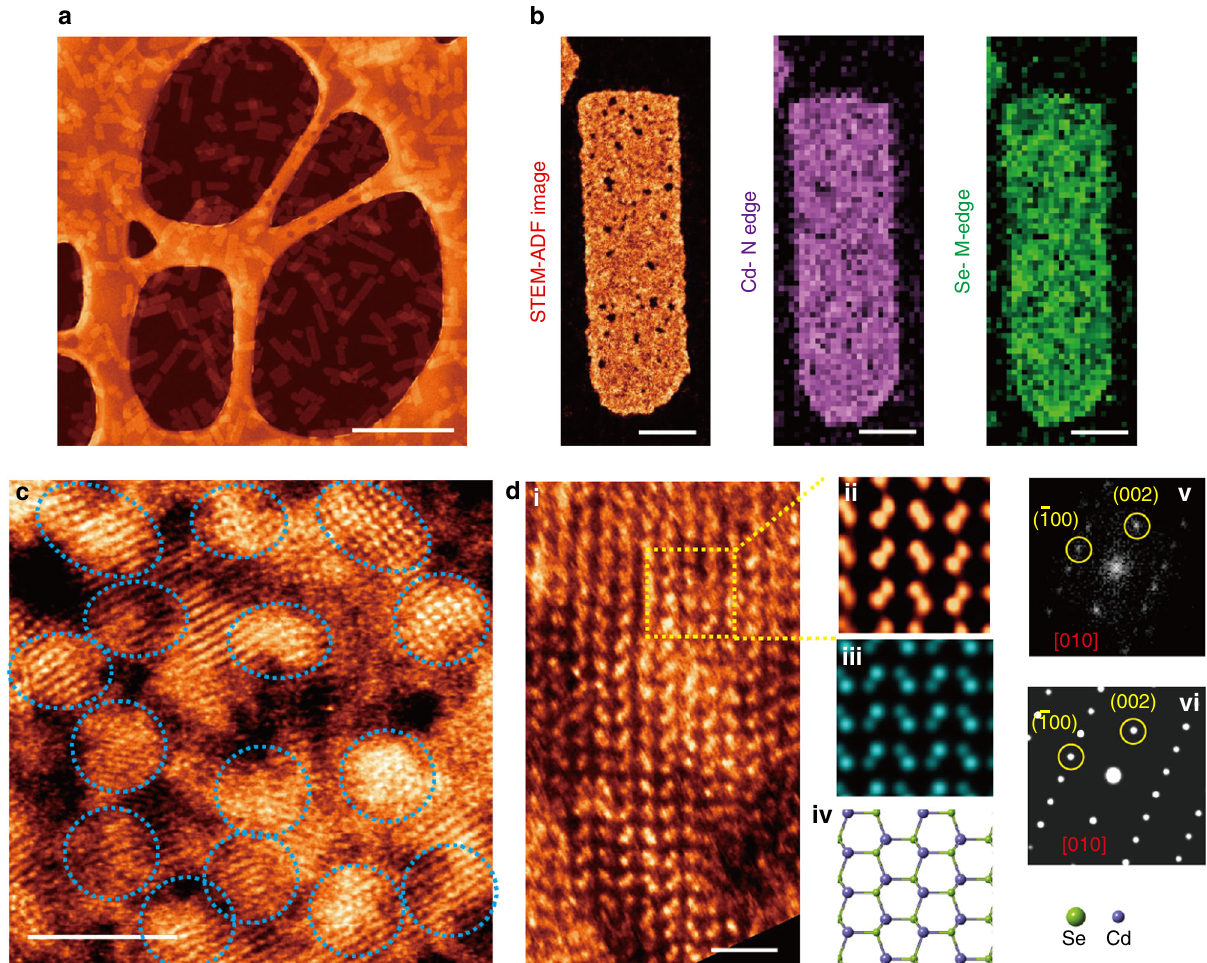
Fig. 2 Porous CdSe nanosheets. a STEM-ADF image of CdSe nanosheets, scale bar: 500 nm; b STEM-ADF image and corresponding EELS mapping of CdSe nanosheets, scale bar: 20 nm; c atomic resolution STEM-ADF image of CdSe nanocrystalline domains, scale bar: 2 nm; and d zooming in on a nanocrystal domain: (ii) enlarged fi ltered image of the region enclosed by the yellow box in (i) with its corresponding (iii) simulated image, (iv) atomic structure, (v) fast Fourier transform (FFT) pattern, and (vi) simulated FFT pattern, scale bar: 1